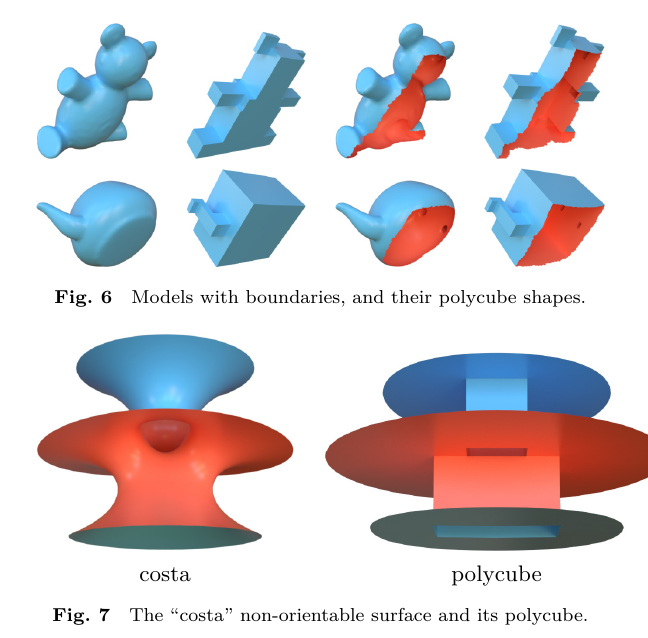
Fig. 7 The “costa” non-orientable surface and its polycube.